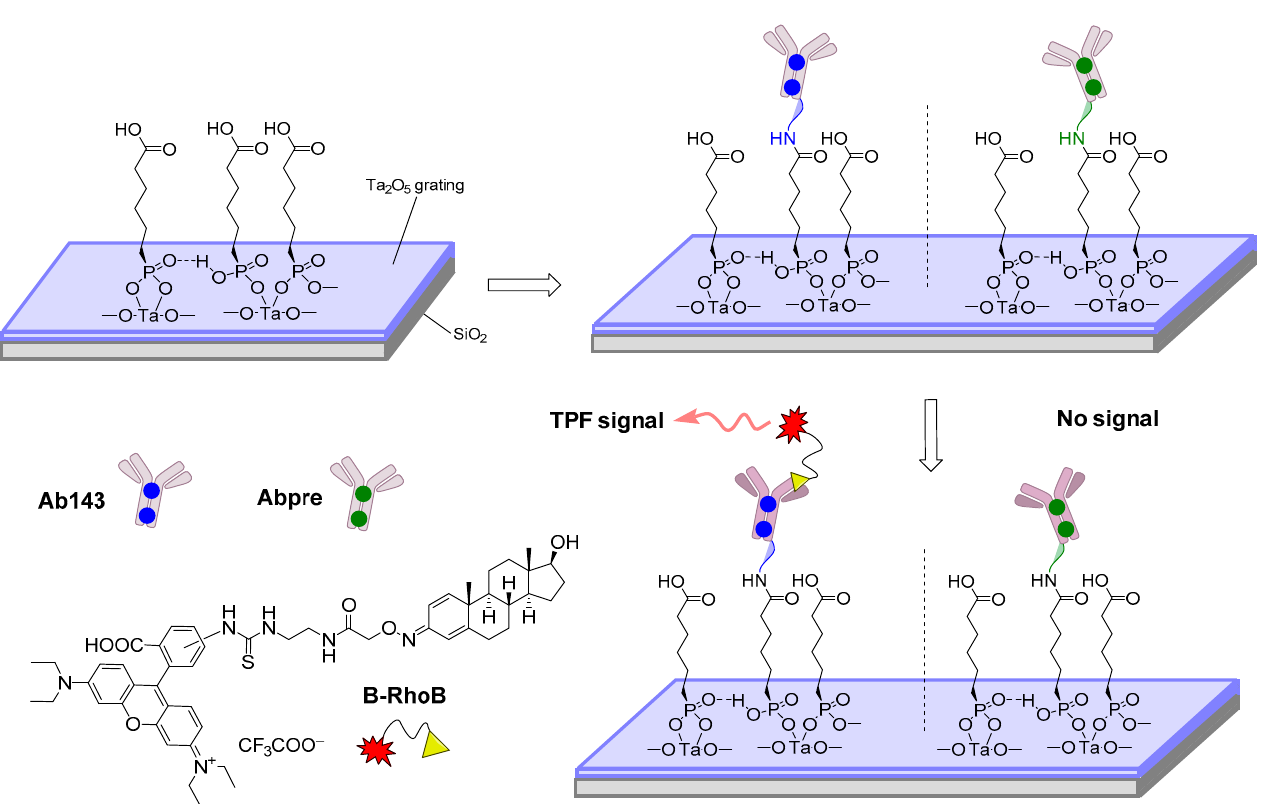
Figure 6. Diagram showing the surface functionalization, covalent immobilization of antibodies (Ab143: specific antibody marked with blue dots, Abpre: non-specific antibody marked with green dots), and the principle of a bioaffinity assay (TPF: two-photon fluorescence emission) using boldenone fluorescently labeled with rhodamine B (B-RhoB) [103].